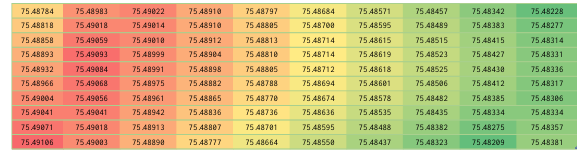
Table 3. Slopes of the fitting straight lines on the left image of the IKONOS dataset (degree)